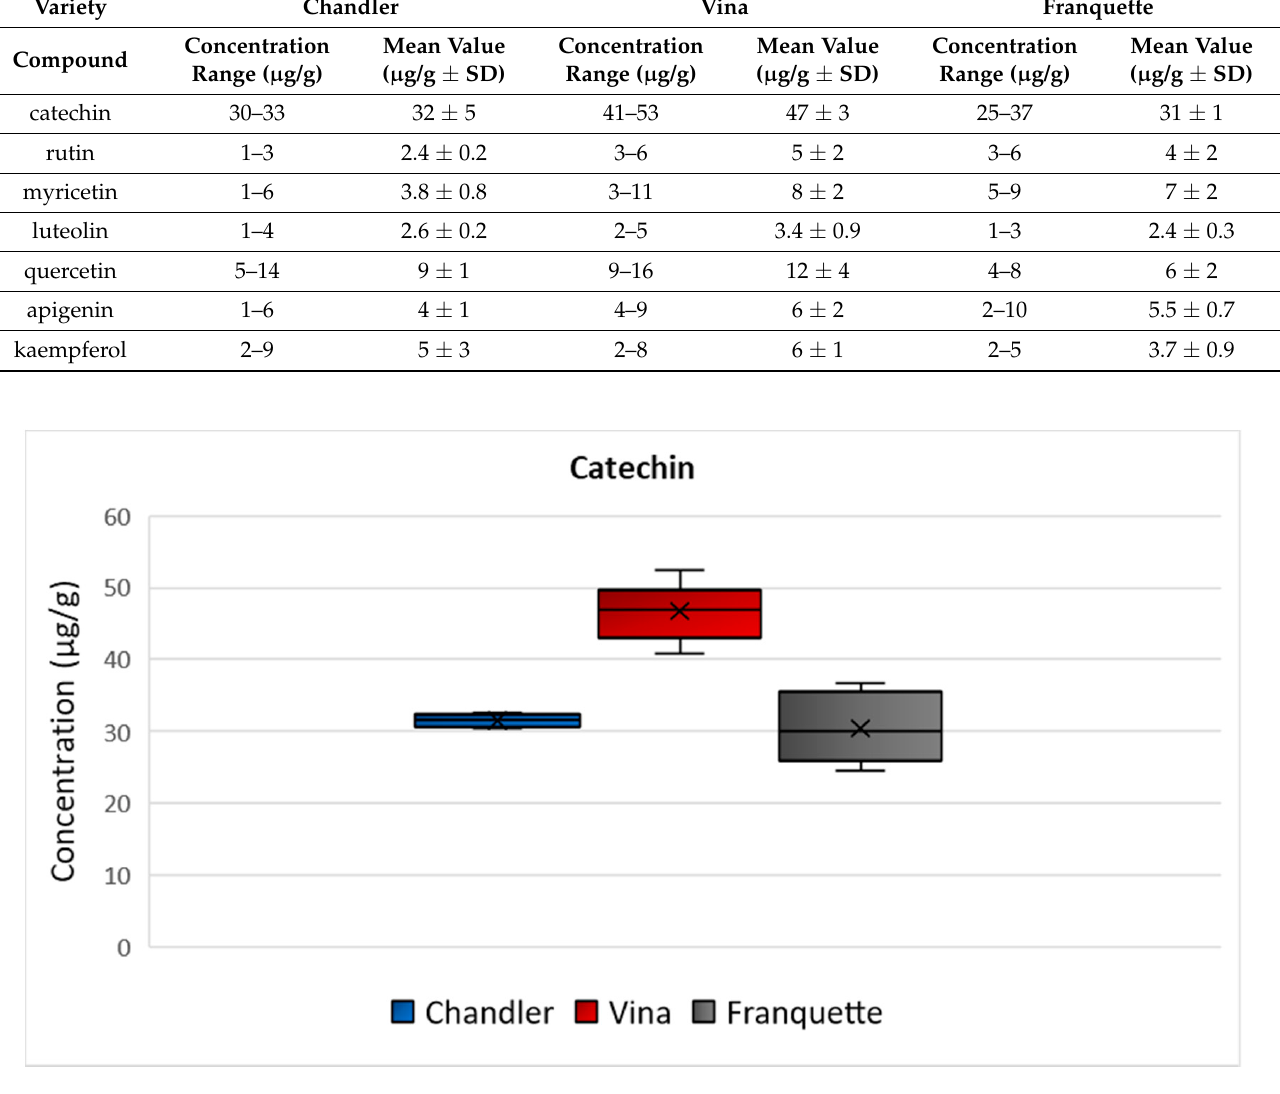
Figure 2. Box and Whisker plot for the concentration of catechin among walnut septa, belonging to the Chandler, Vina, and Franquette varieties.